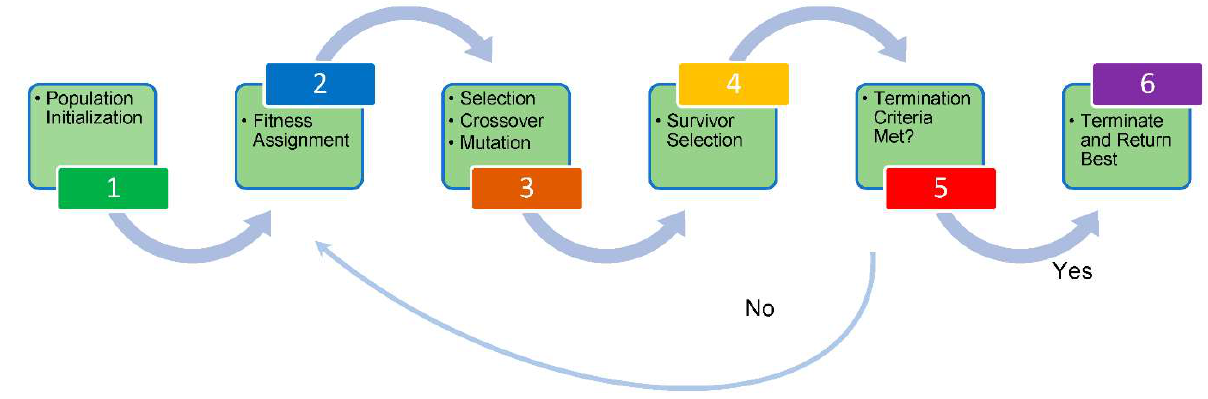
Figure 10. Process flow of genetic Algorithm.